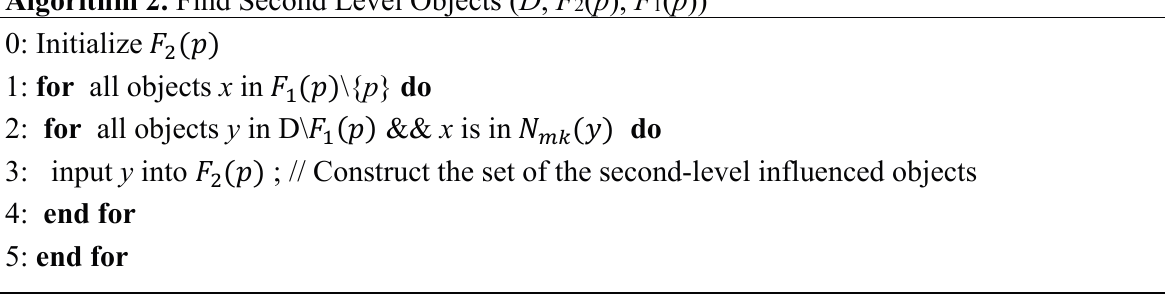
Algorithm 2. Find Second Level Objects ( D , F 2 ( p ), F 1 ( p